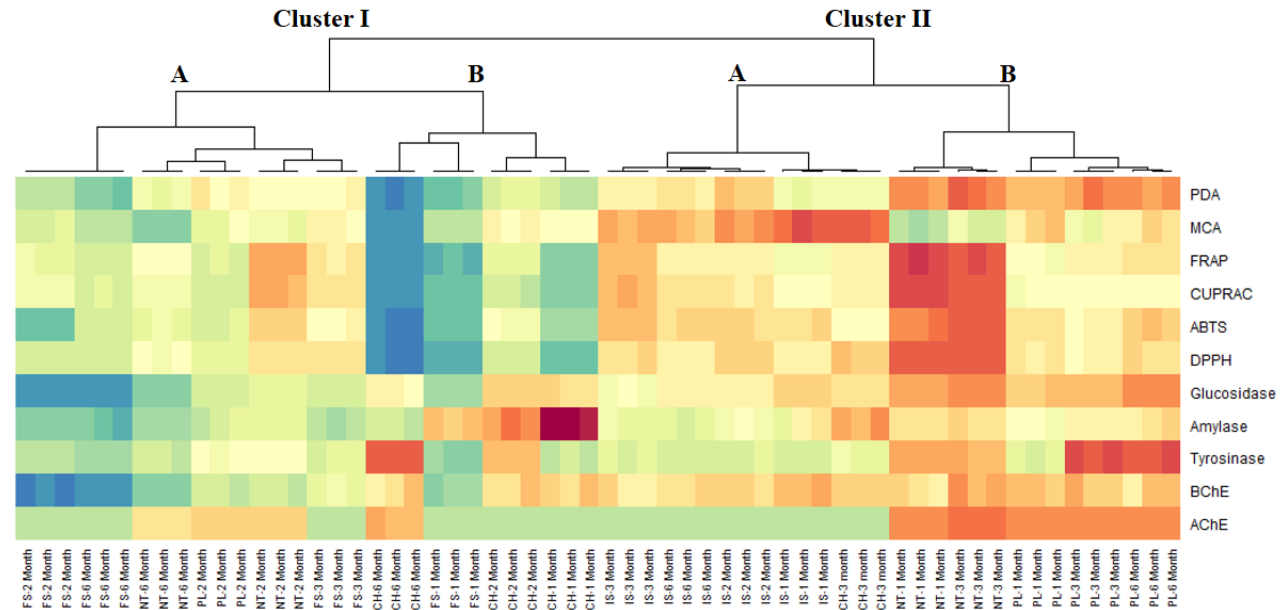
Figure 4. Cluster image map (CIM) analysis of the antioxidant and anti-enzymatic activity data of comfrey roots (red color: high activity, blue color: low activity). ABTS, 2,2′ -azino-bis(3-ethylbenzothiazoline) 6-sulfonic acid; AChE, acetylcholinesterase; BChE, butyrylcholinesterase; CUPRAC, cupric ion reducing antioxidant capacity; DPPH, 1,1-diphenyl-2-picrylhydrazyl; FRAP, ferric ion reducing antioxidant power; MCA, metal chelating activity; PDA, phosphomolybdenum activity.